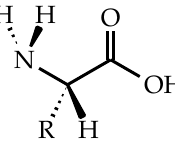
Figure 1. Structure of an L -amino acid that possesses an α -amine group (-NH 2 ), carboxylate group (-COOH) and a side chain (-R).